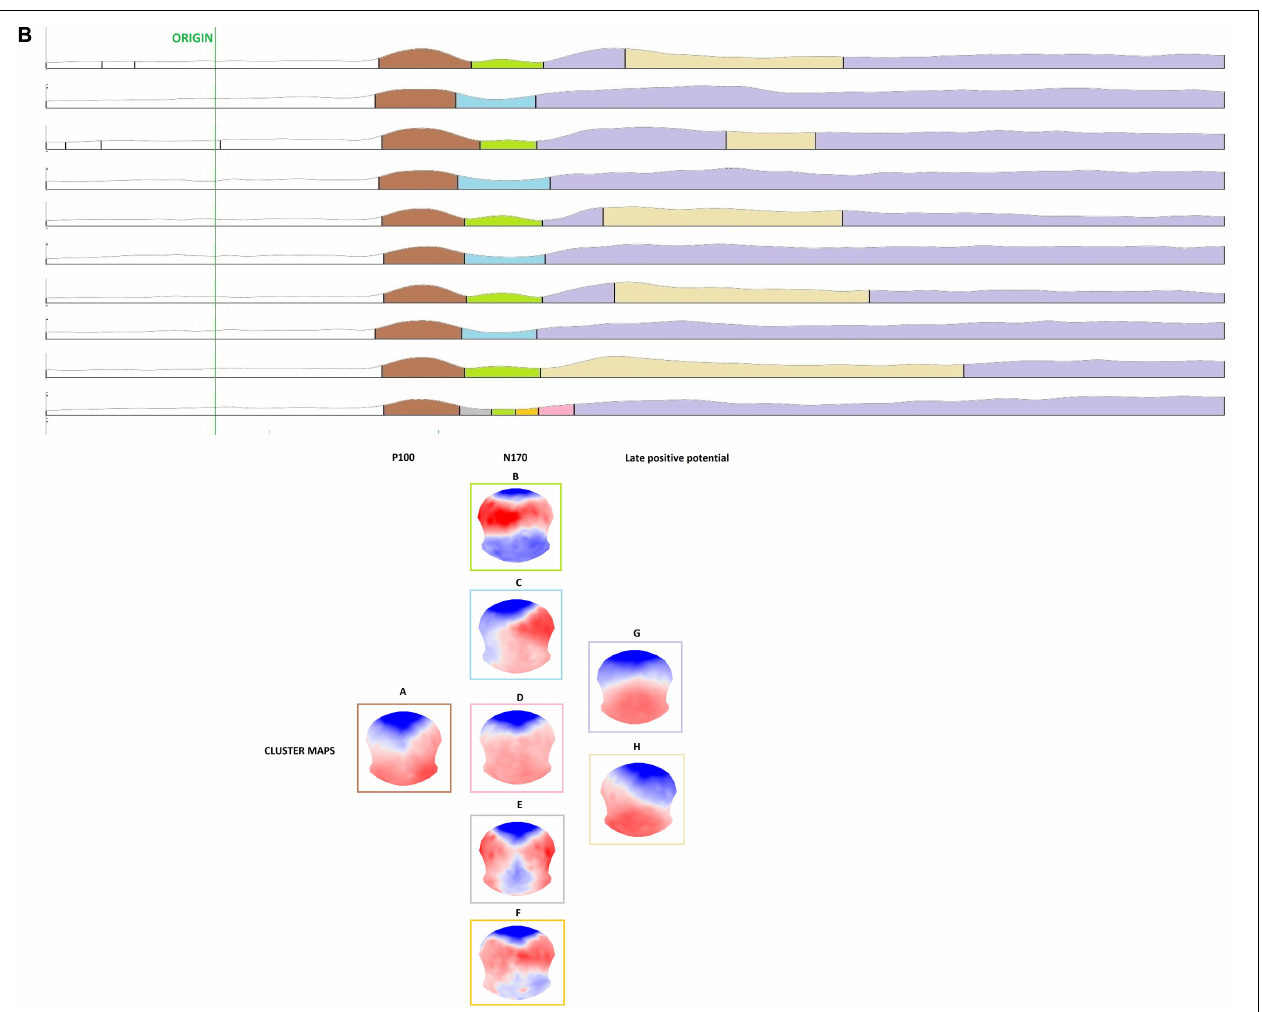
FIGURE 3 | Cluster analysis of the grand mean ERPs where microstates are presented in different colors, as well as their corresponding cluster-maps. (A) Microstates of the five degrees of the dominance dimension (Dominance = 1–5) and for each group, as well as corresponding topographical maps. Each evoked potential was represented by specific microstates and topographical maps (P1 = microstate Class A; N170 = microstate Classes B, C, D, E, and F; LPP = microstate Classes G and H). (B) Microstates of the five degrees of the trustworthiness dimension (Trust = 1–5) and for each group, as well as corresponding topographical maps. Each evoked potential was represented by specific microstates and topographical maps (P1 = microstate Class A; N170 = microstate Classes B, C, D, and E; LPP = microstate Classes G and